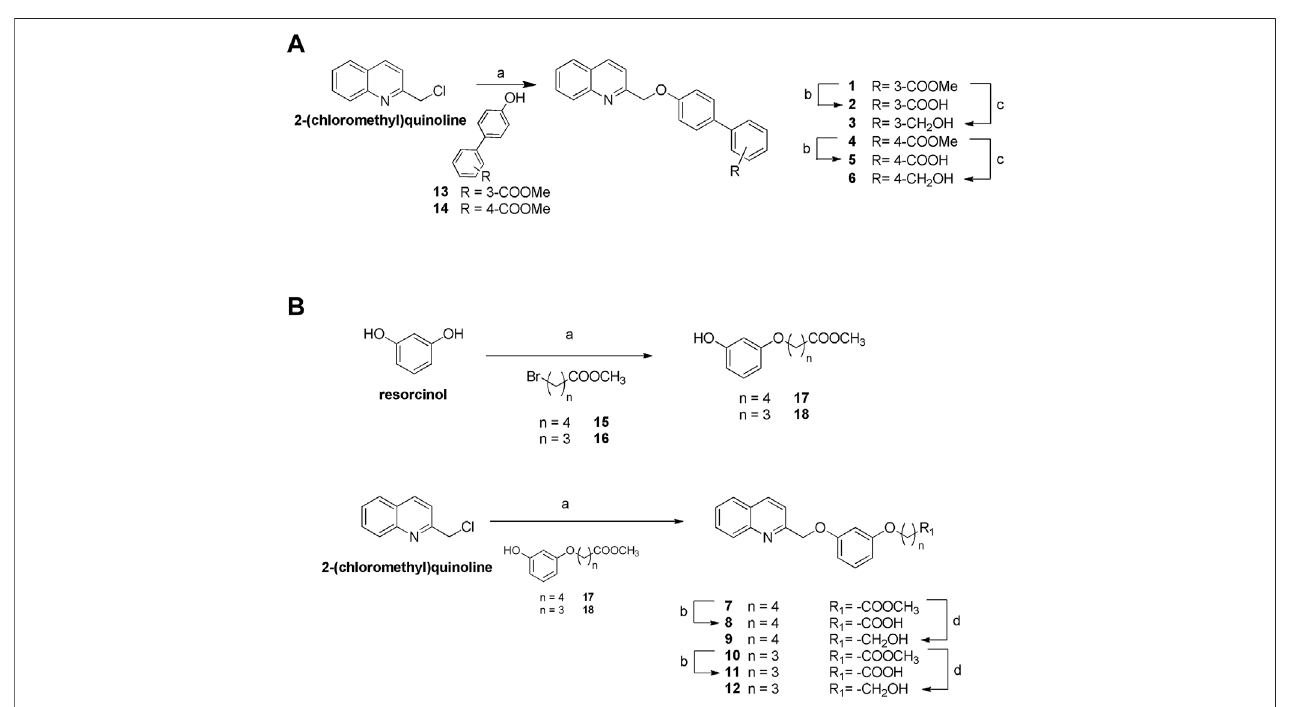
FIGURE 2 | Synthesis of compounds 1 – 12. (A) Reagents and conditions. a ) Compounds 13 or 14, K 2 CO 3 , dry DMF, 100 ° C, quantitative yield and 87%, respectively; b ) NaOH in excess, MeOH: H 2 O 1:1 v/v, re fl ux, quantitative yield for both reactions; c ) DIBAL-H, dry THF, 0 ° C, quantitative yield and 92%, respectively.